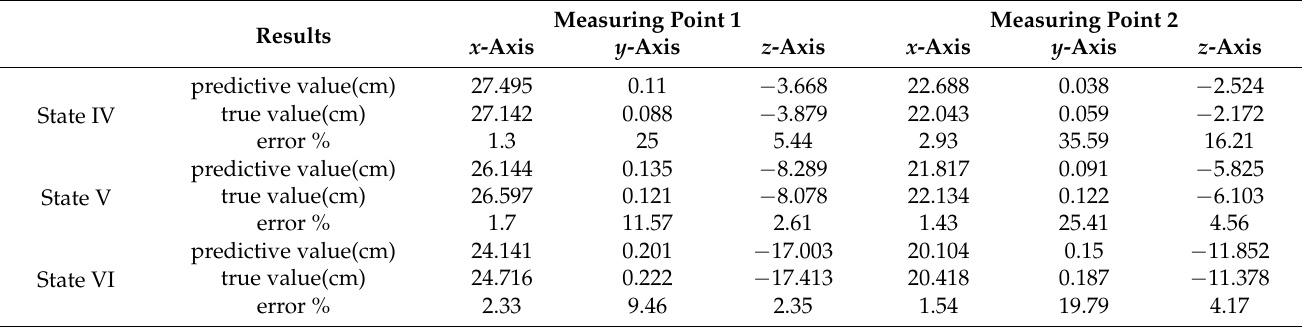
Table 8. Figure 11b comparison of measuring point